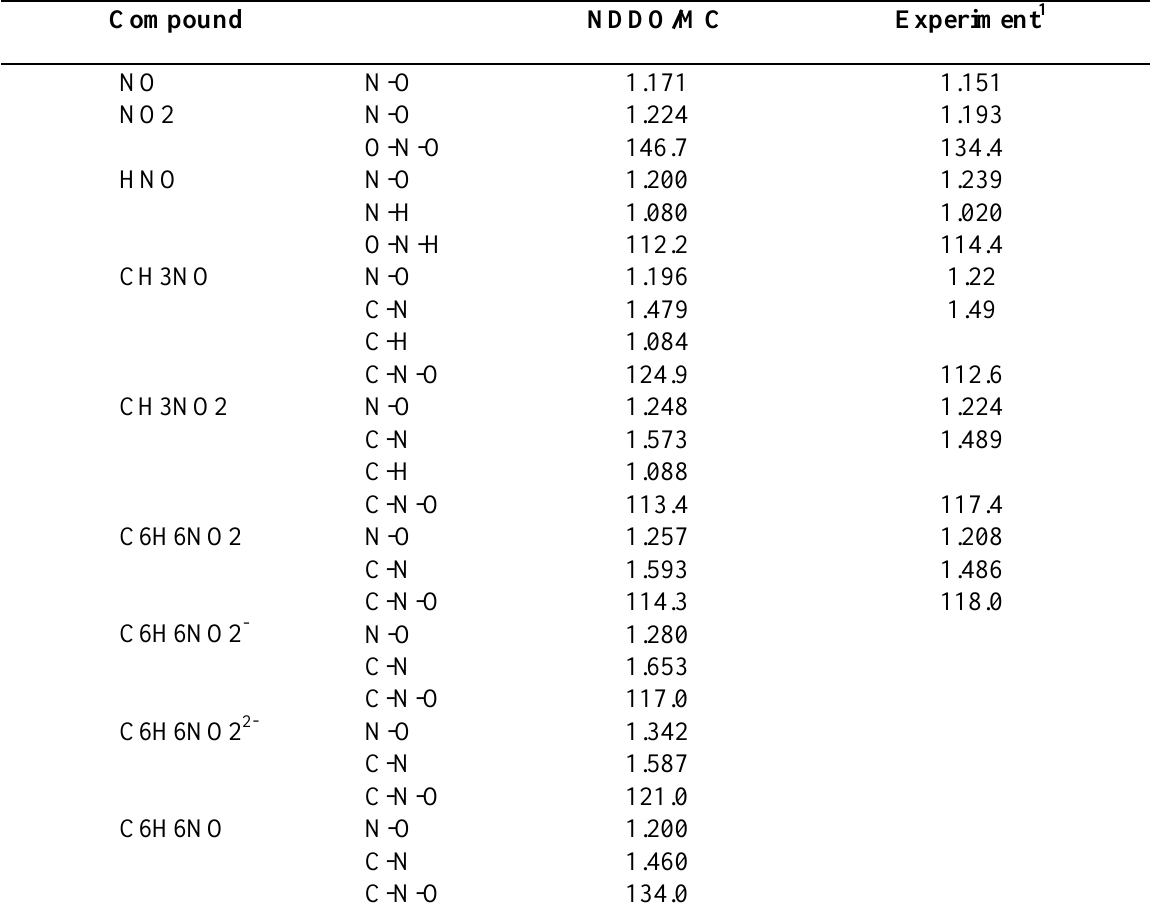
Table 1. Bond length (Å) and valence angles (degree) of the nitro compounds as revealed by the NDDO/MC